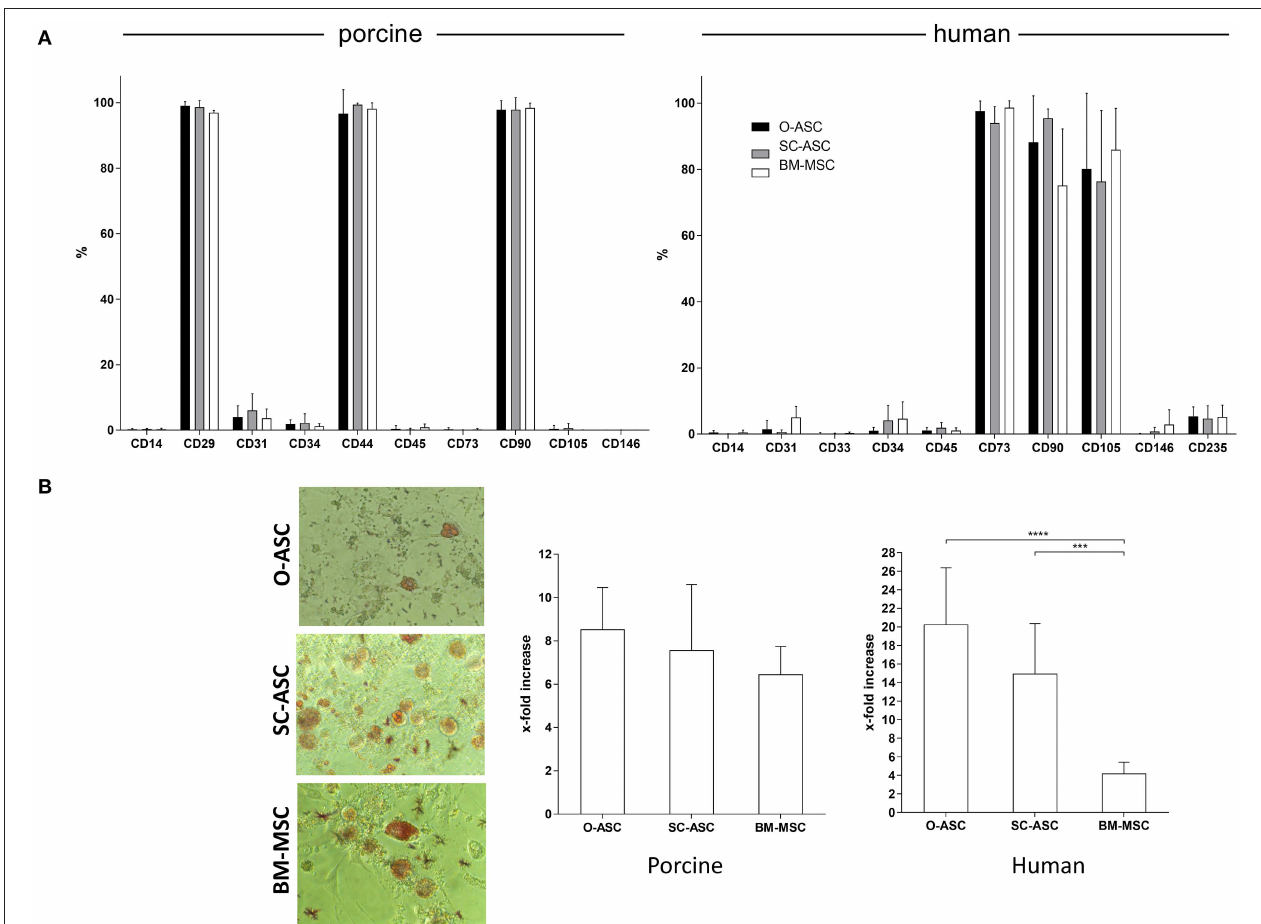
FIGURE 3 | Cell surface marker phenotype and adipogenic differentiation. The three cell lines (O-ASC, SC-ASC, and BM-MSC) were analyzed for their surface marker phenotype by flow cytometry ( A ; Bencton FACS Aria). CD73 showed no cross-reaction. Porcine cells: O-ASC n = 9, SC-ASC n = 7, BM-MSC n = 4 runs. Human cells: O-ASC n = 4, SC-ASC n = 4, BM-MSC n = 3 runs. Expressed as %. Error bars = SD. Adipogenic differentiation assays were performed with passage 3 cells in triplicates. Differentiation was quantified by fluorescence after Adipored ® staining. ( B left panel) Representative microscopic pictures. ( B right panel) Results expressed as x-fold increased intensity compared to controls. Error bars = SD. Two-way ANOVA with Tukey post-test. *** p < 0.001, **** p < 0.0001.